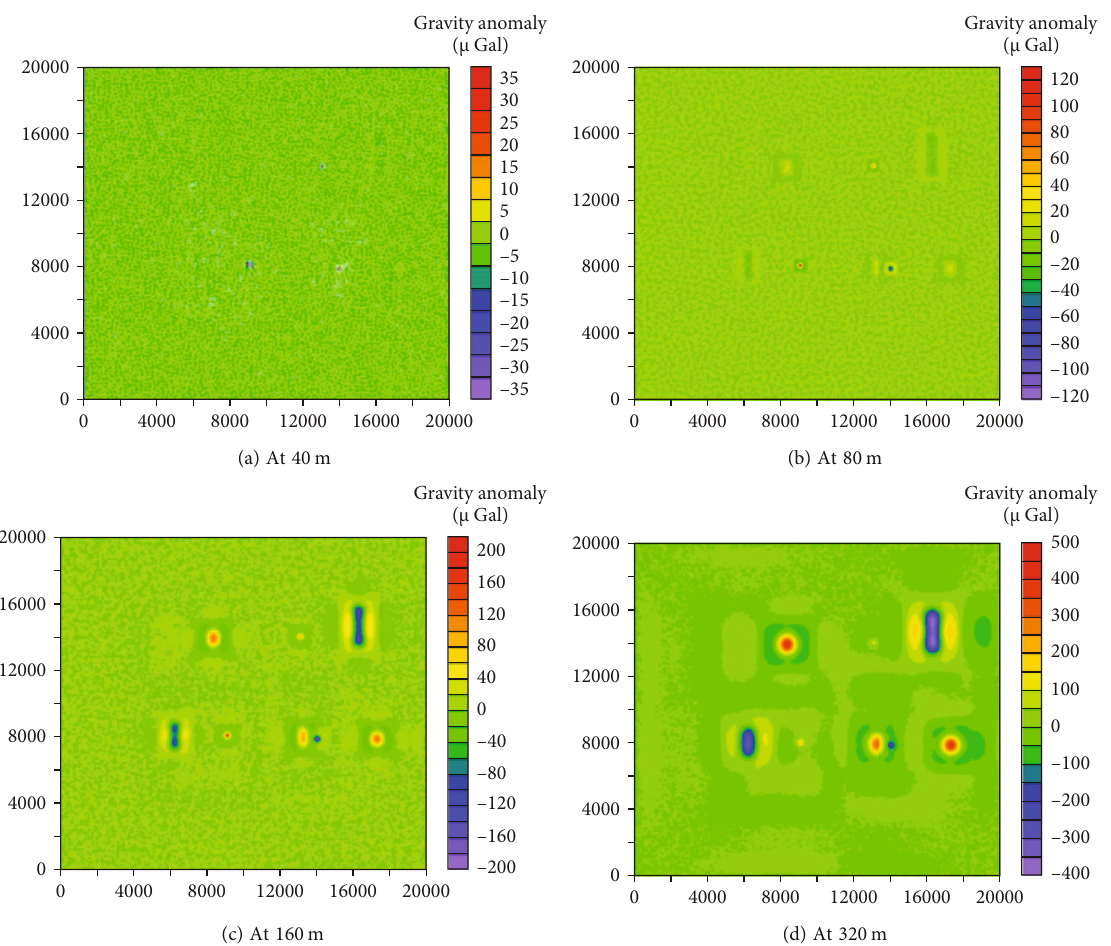
Figure 3: Residual gravity anomaly maps at di ff erent